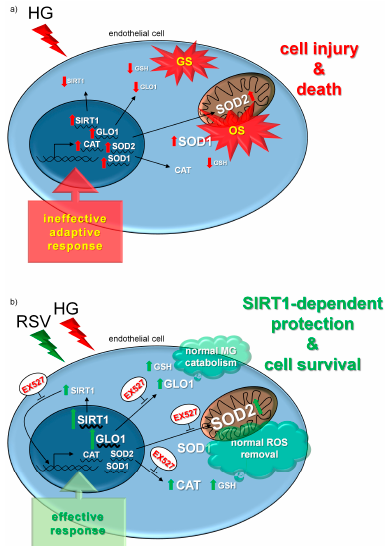
Figure 7. Synoptical interpretation of the experimental results. A 24-h treatment with HG induced both GS and OS in HUVECs by reducing SIRT1 activity, as well as by diminishing the efficiency of MG- and ROS-targeting defense. An attempt of compensation occurred at transcriptional level, however this was ineffective, as HG promoted apoptotic and necrotic cell death ( a ). The cytotoxic effects of HG were abolished by the co-treatment with RSV, and this was associated with transcriptionally-regulated restoration of SIRT1 activity, together with increased expression of GLO1, improved ROS-scavenging efficiency, and total suppression of HG-related GS and OS. The RSV-induced effective response to HG cytotoxicity was abolished by the specific inhibitor of SIRT1 (i.e., EX527), and this started at the level of mRNA transcription, thus suggesting that the upregulation of SIRT1 was essential for RSV to activate the major antioxidative and antiglycative defense, and avoid ROS- and MG-dependent molecular damages in a high glucose environment ( b ). Abbreviations: CAT—catalase; HG—high glucose; GLO1—glyoxalase 1; GS—glycative stress;